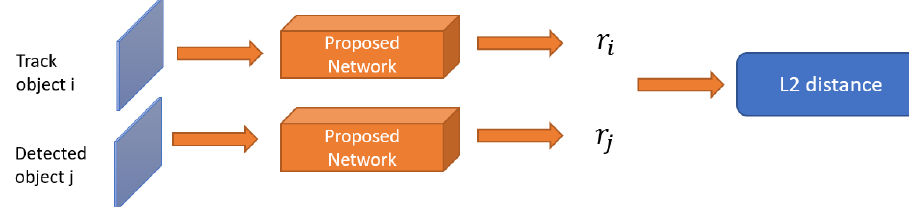
Figure 9. Appearance distance between objects.